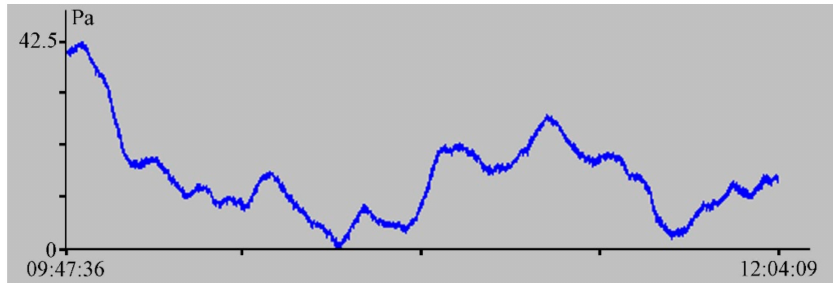
Figure 8. Fragment of laser nanobarograph record for 1 March 2016, UTC.